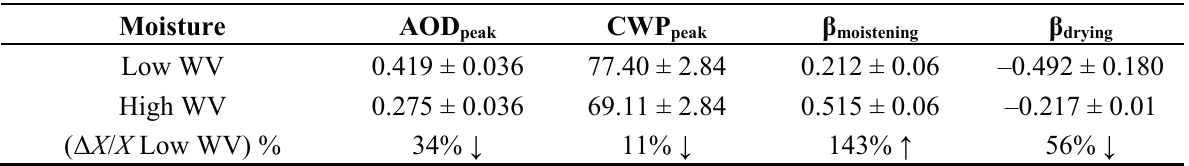
Table 3. Comparison of percent increase ( ↑ ) or decrease ( ↓ ) in the characteristics parameters of cloud water path response curve aerosol induced perturbation from low to high water vapor environment